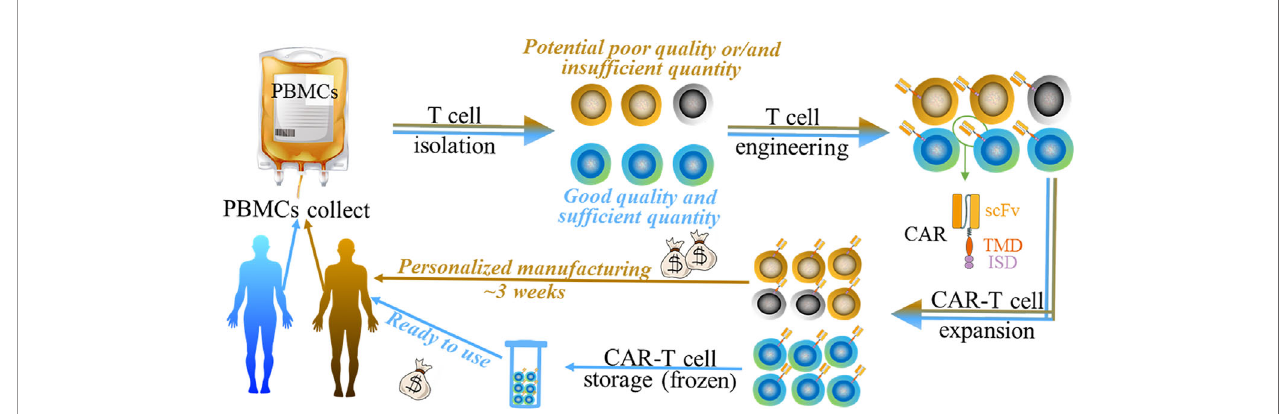
FIGURE 1 | The generalized manufacturing procedure of autologous chimeric (brown arrow indicated) and UC therapy (blue arrow indicated). Both of them undergo 1) PBMC collect; 2) T cell isolation; 3) T cell engineering; 4) CAR-T cell expansion, and 5) CAR-T cell storage (only for UC therapy). Autologous CAR product may have disadvantages such as money-, time- consuming, and the potential poor quality/quantity of patient-derived cells (black/grey cells indicated). UC therapy product has various potential bene fi ts such as simplifying and standardizing the manufacturing at relatively lower